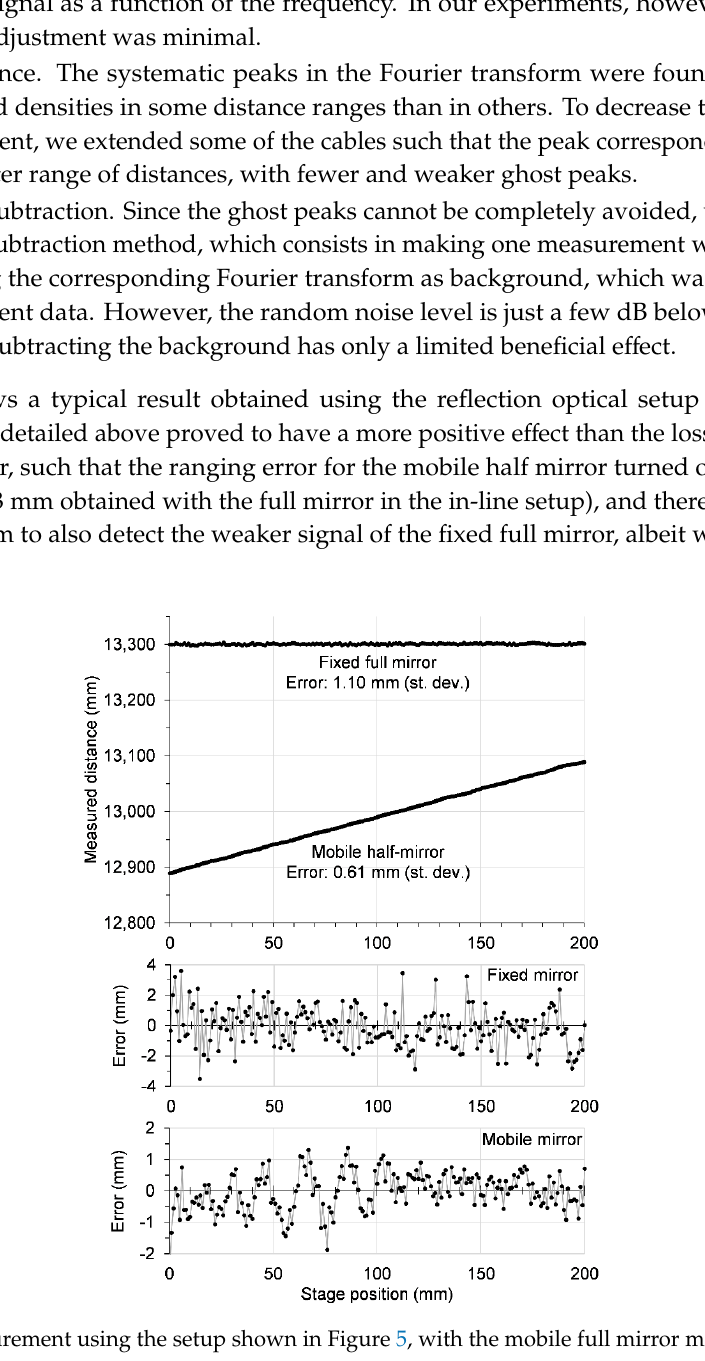
Figure 6. Measurement using the setup shown in Figure 5, with the mobile full mirror moved in 1-mm steps over a distance of 200 mm. The top graph shows the measured distance as a function of the motor stage position. The measurement error for each target is shown in the two bottom plots, where the error is defined as the difference between the measured data and a linear fit with slopes 0 and 1 for the fixed and mobile mirrors, respectively.